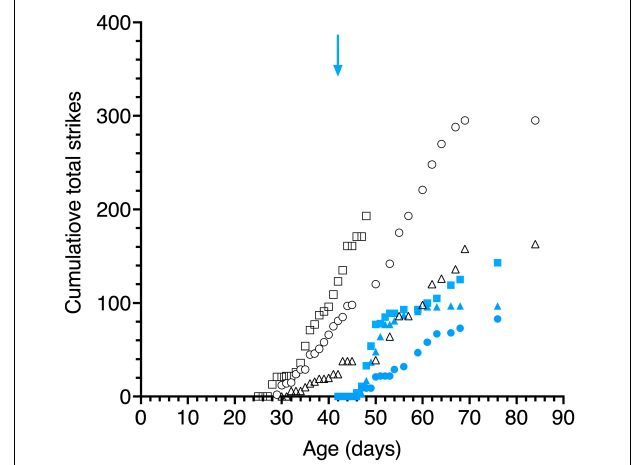
FIGURE 8 | Cumulative total strikes to the swinging small pendulum in daily 15 s episodes as a function of age. Data are displayed for 3 light- exposed (open black symbols: C117 triangles, C118 circles, C119 squares) and 3 dark-reared kittens (blue filled symbols: C114 triangles, C115 circles, C116 squares). The blue arrow indicates the age of the dark-reared kittens when they were first exposed to